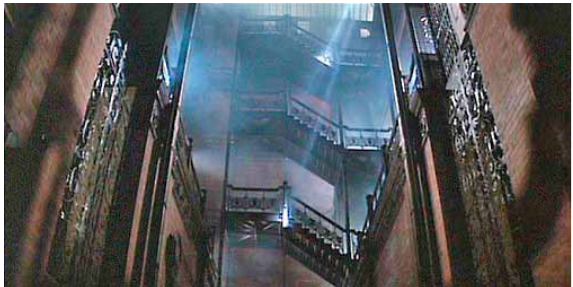
fig. 12. The Bradbury Building in Blade Runner